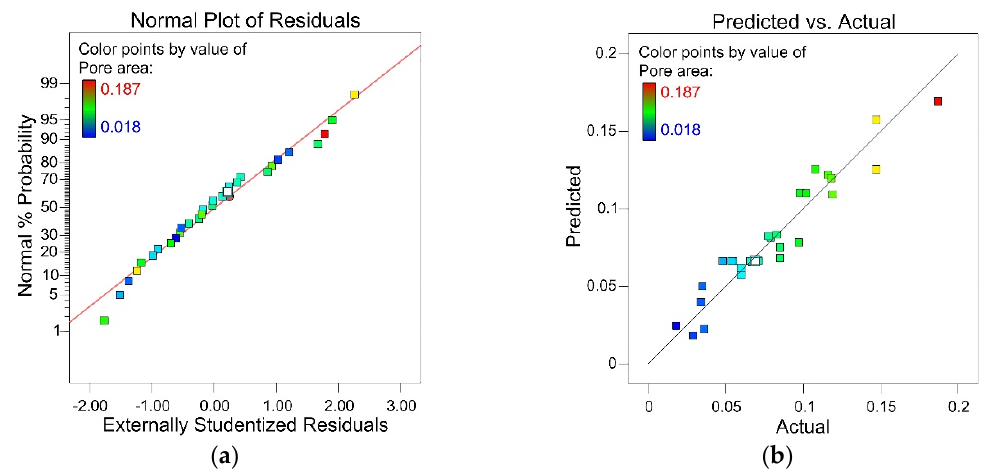
Figure 8. ( a ) Residual plot of the pore area; ( b ) Comparison of predicted and actual pore area.